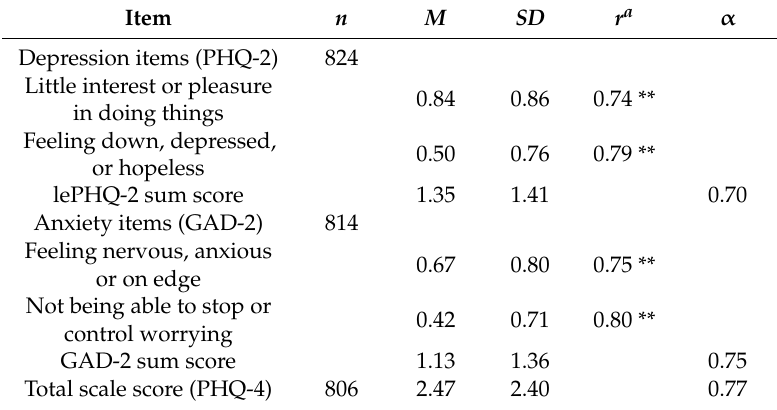
Table 2. Characteristics of the PHQ-4 items and subscales in the Spanish pregnant population.